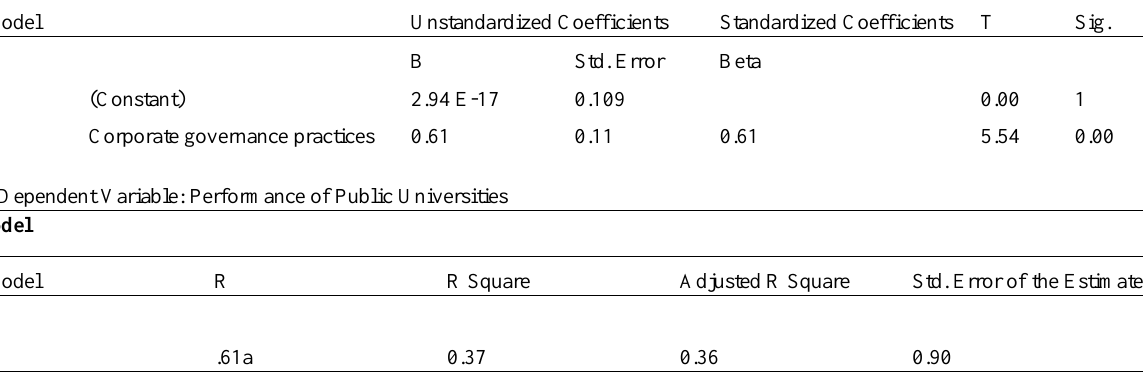
Table 7: Regression Analysis on Adherence to Corporate Governance